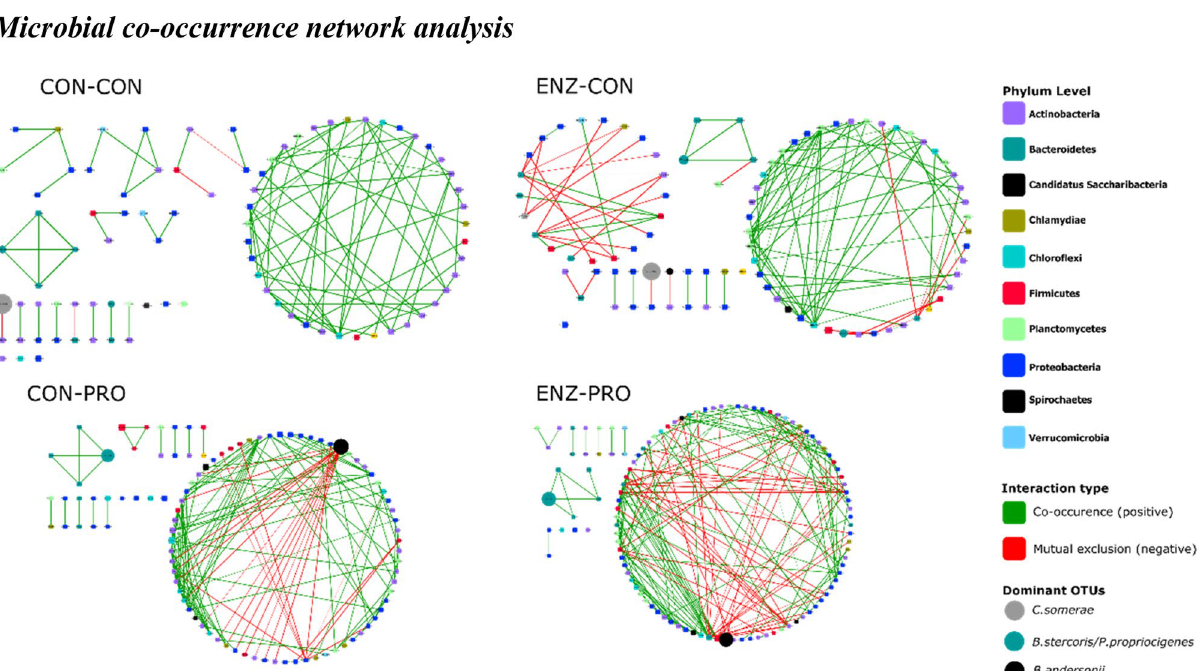
Figure 6. The microbial co-occurrence network in each of the four dietary groups. The nodes represent the interacting OTUs, coloured based on their phylum taxa. The size of each node is proportional to the relative abundance of the OTU. The edges are the lines connecting the OTUs, with colour indicating the type of interaction (green for copresence/positive co-occurrence; red for mutual exclusion/negative co-occurrence). The edge thickness corresponds to the statistical significance (the P value) of the correlation—the thicker the edge, the lower the P value. The dominant species were indicated in ellipse nodes. The networks were produced by CoNet app, within Cytoscape software (version 3.7.1; http:// apps. cytos cape. org/ apps/ conet). CON-CON, no enzymes or probiotics added; CON-PRO, probiotics added; ENZ-CON, enzymes added; ENZ-PRO, enzymes and probiotics